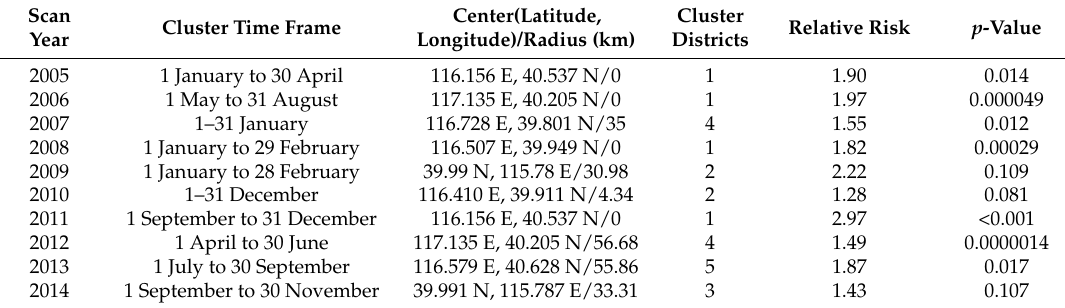
Table 4. The most likely high-risk clusters of scarlet fever incidence detected using a space-time permutation model (setting 50% as the maximum cluster size) in Beijing, 2005–2011.